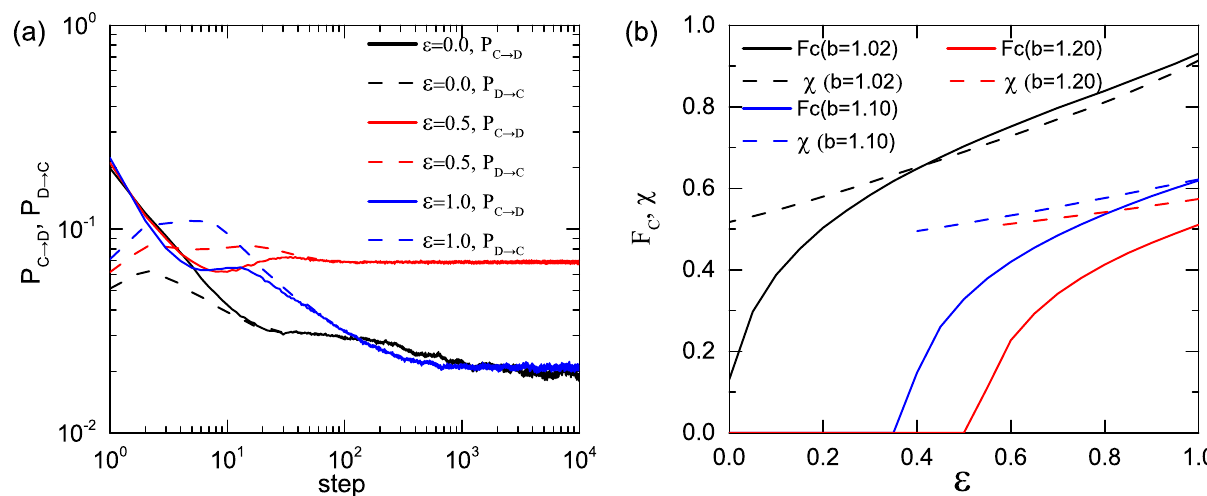
Fig 3. The analysis of strategies transform and the compactness of cooperator clusters. (a) Time evolution of the fraction of individuals whose strategies transform from cooperation to defection (defection to cooperation) P C ! D ( P D ! C ) for ε = 0.0, 0.5, 1.0. The game parameter b = 1.02. (b) Fraction of cooperators F (solid line) and ratio χ (dashed line) as functions of the strength of preferential selection ε for b = 1.02, 1.10, 1.20. C